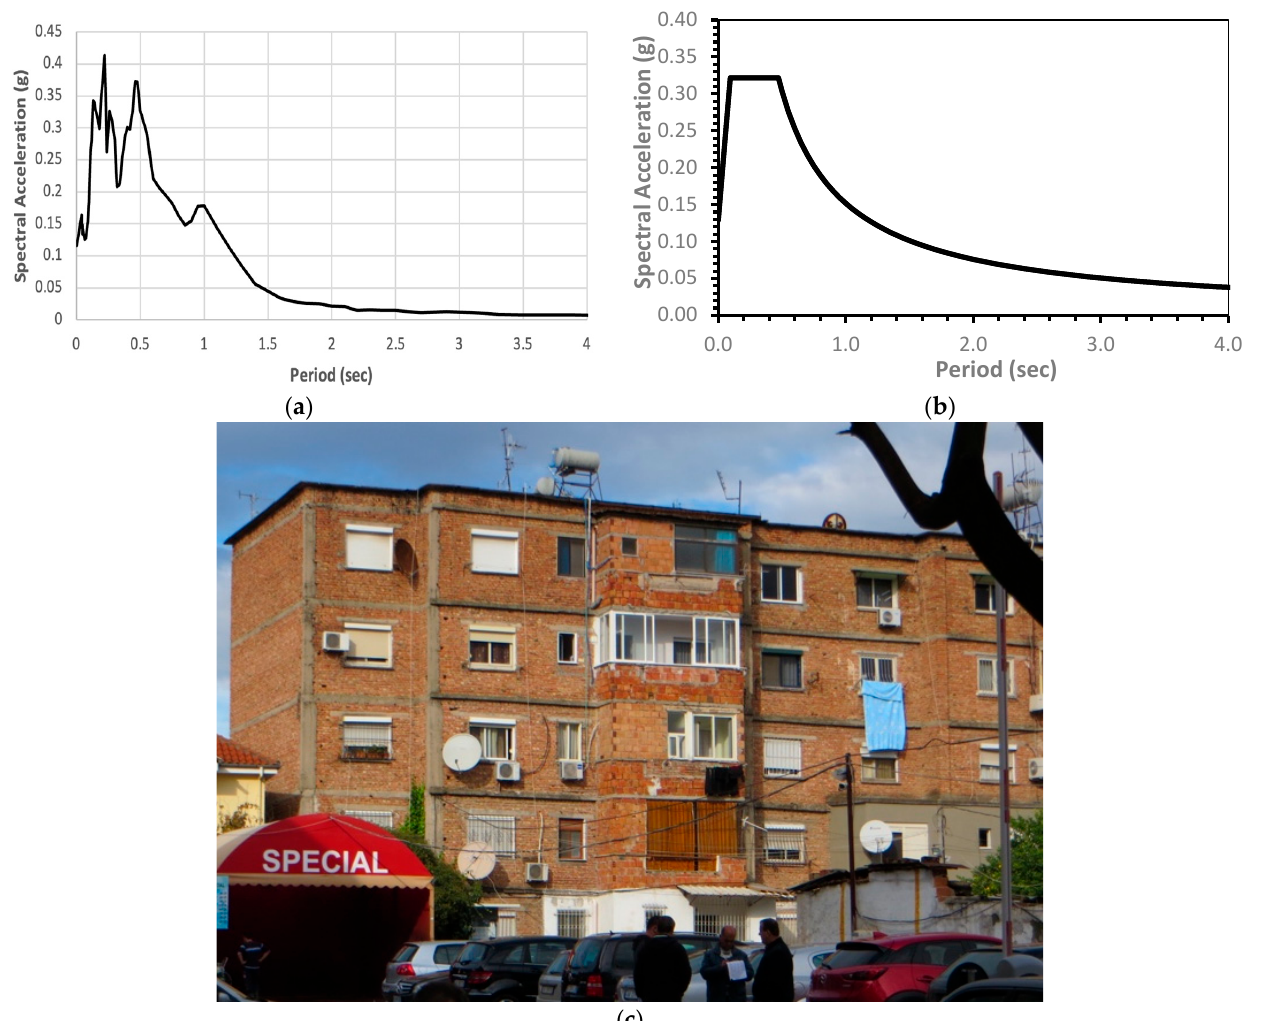
Figure 1. Some of the site and building-specific parameters: ( a ) site-specific acceleration response spectrum; ( b ) design acceleration response spectrum; ( c ) URM building with corner columns and rigid floor (Bekta ş [50]).